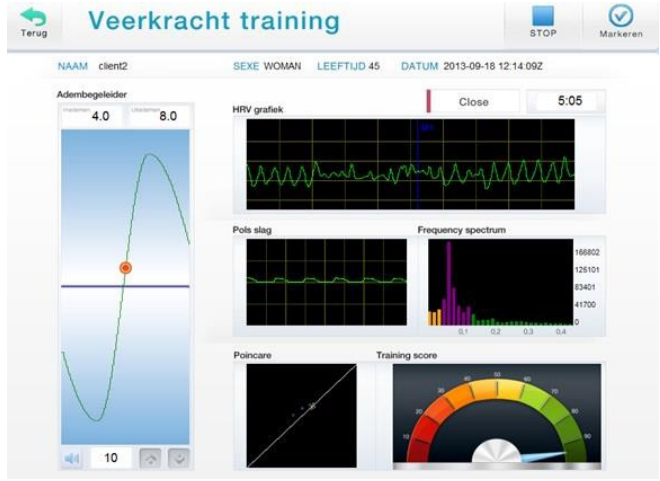
Figure 6. Balance Manager.